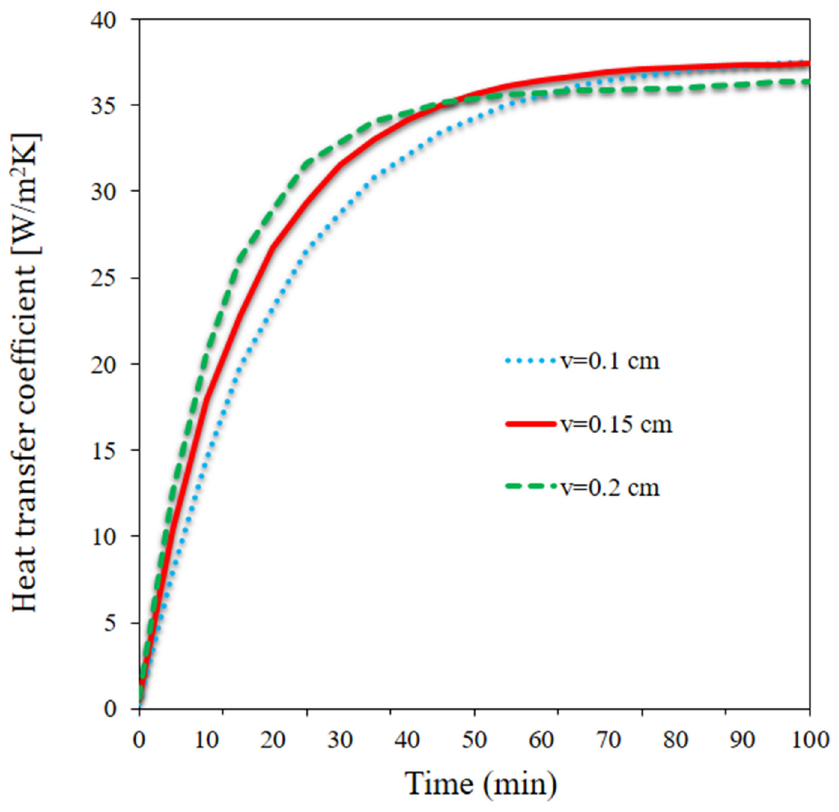
Figure 8. The HTR coefficient between the pipes and panel at three velocities over time.